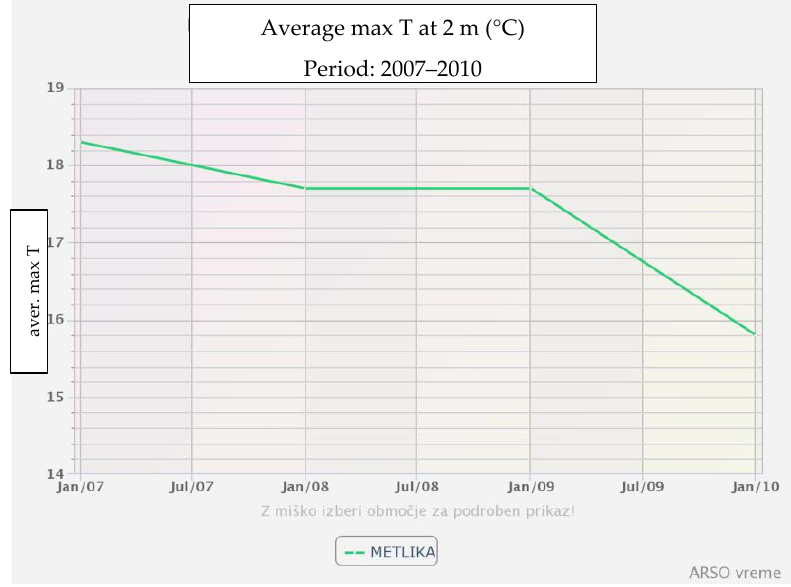
Figure 6. Average maximum temperature for localities 16—Božakovo, measured from nearby climate station Metlika (source: https://meteo.arso.gov.si/met/sl/archive, accessed on 27 January 2023).